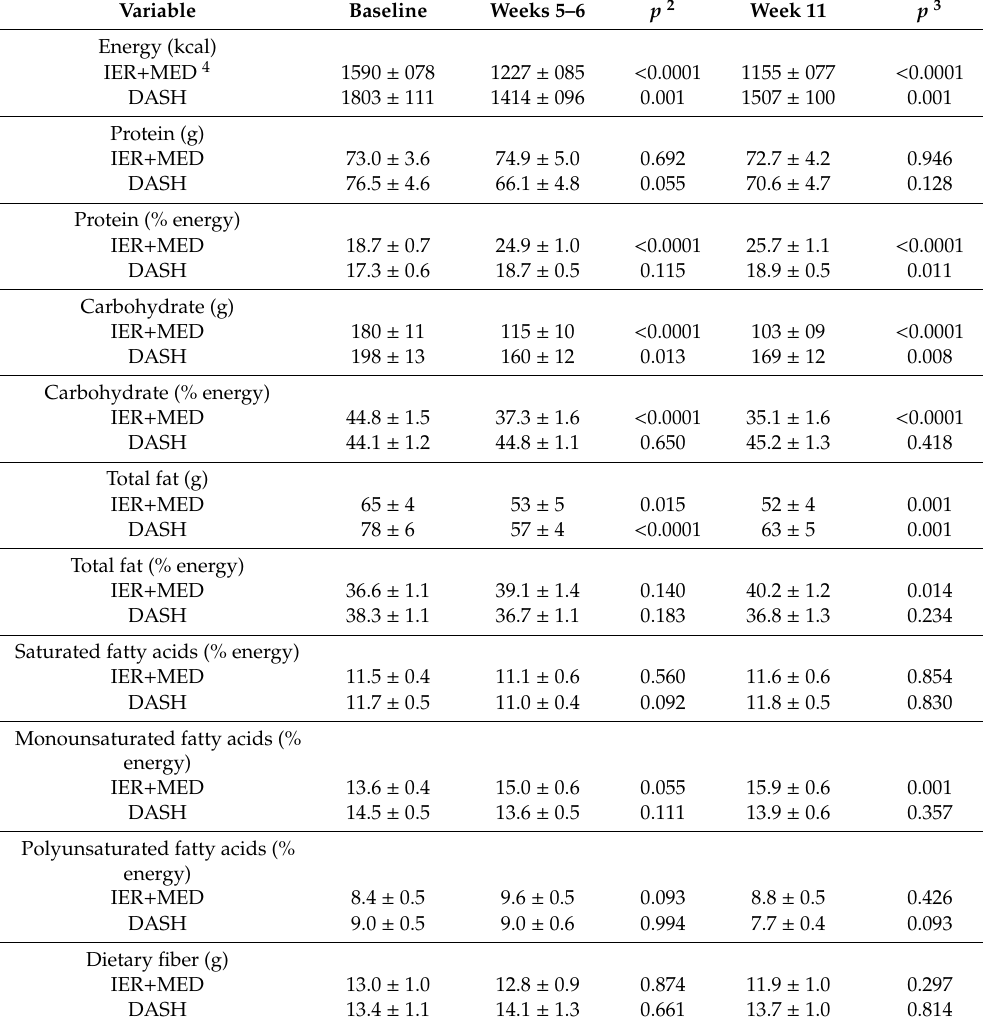
Table 2. Dietary intake assessed using 4-day mobile food records (mFR ™ ) captured by participants in the IER + MED group ( n = 30) and the DASH group ( n = 30) across three time points 1